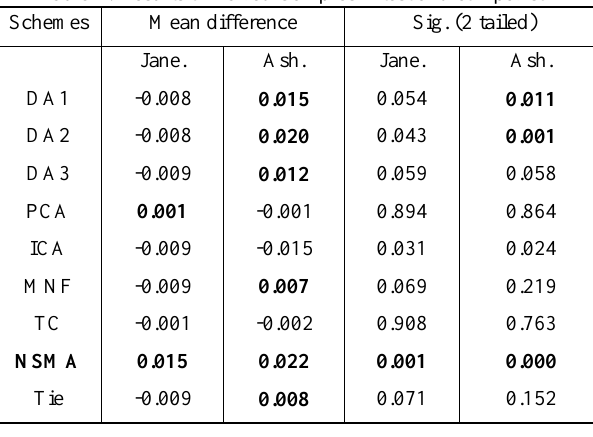
Table 2. Results of Paired-Samples T test and